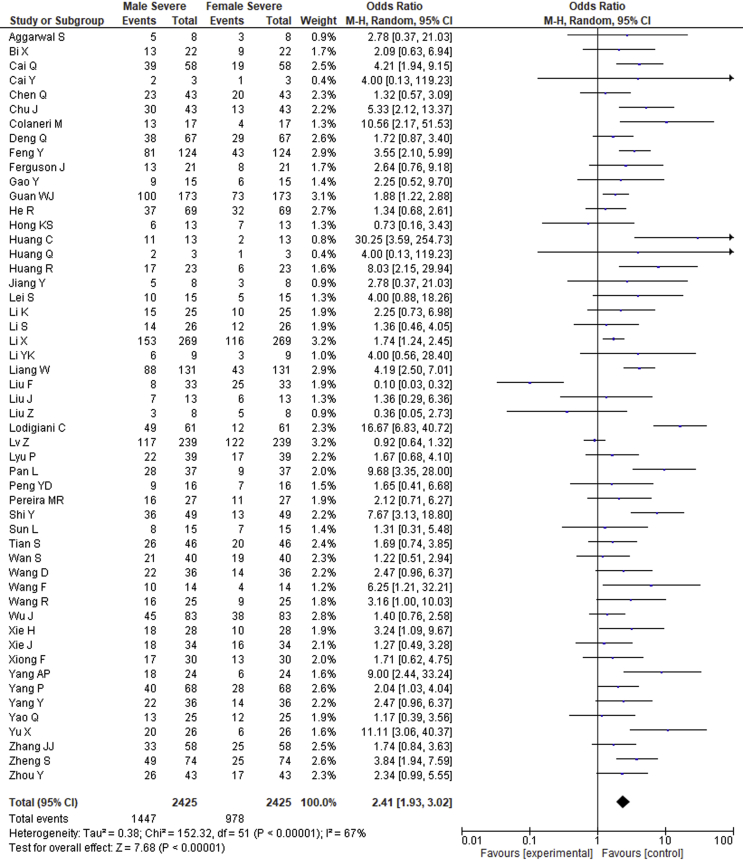
Meta-analysis for the effect of sex on the severity of COVID-19 cases. Forest plots depict the comparison of the incidences of male and female in severe and nonsevere patients.